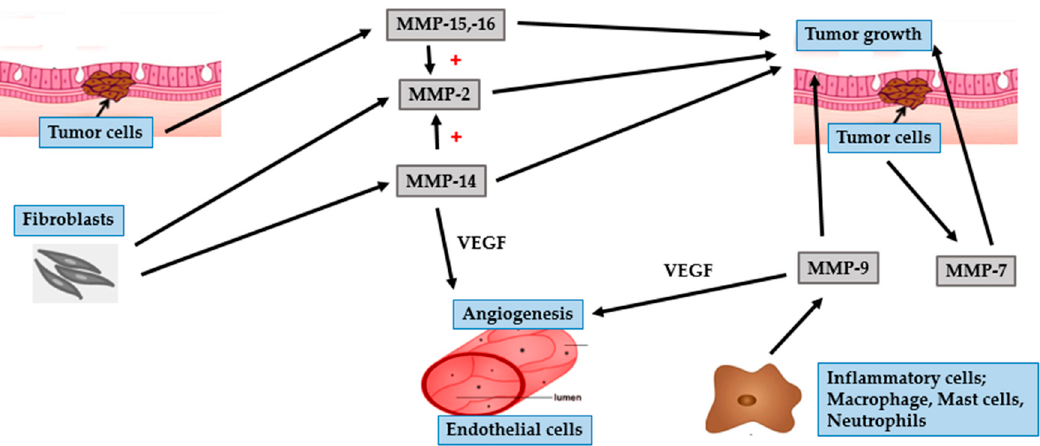
Figure 6. Role of MMPs in malignant melanoma and tumor growth. Melanoma cells secrete MMP-15 and MMP-16 to promote tumor growth. Fibroblasts secrete MMP-2 (also activated by MMP-14, MMP-15, and MMP-16) and MMP-14 to induce tumor growth. In addition to growth initiation, MMP-14 promotes tumor angiogenesis by enhancing the expression of VEGF. Inflammatory cells-derived MMP-9 is involved in tumor development and tumor angiogenesis. MMP-7 produced by melanoma cells can enhance tumor growth.